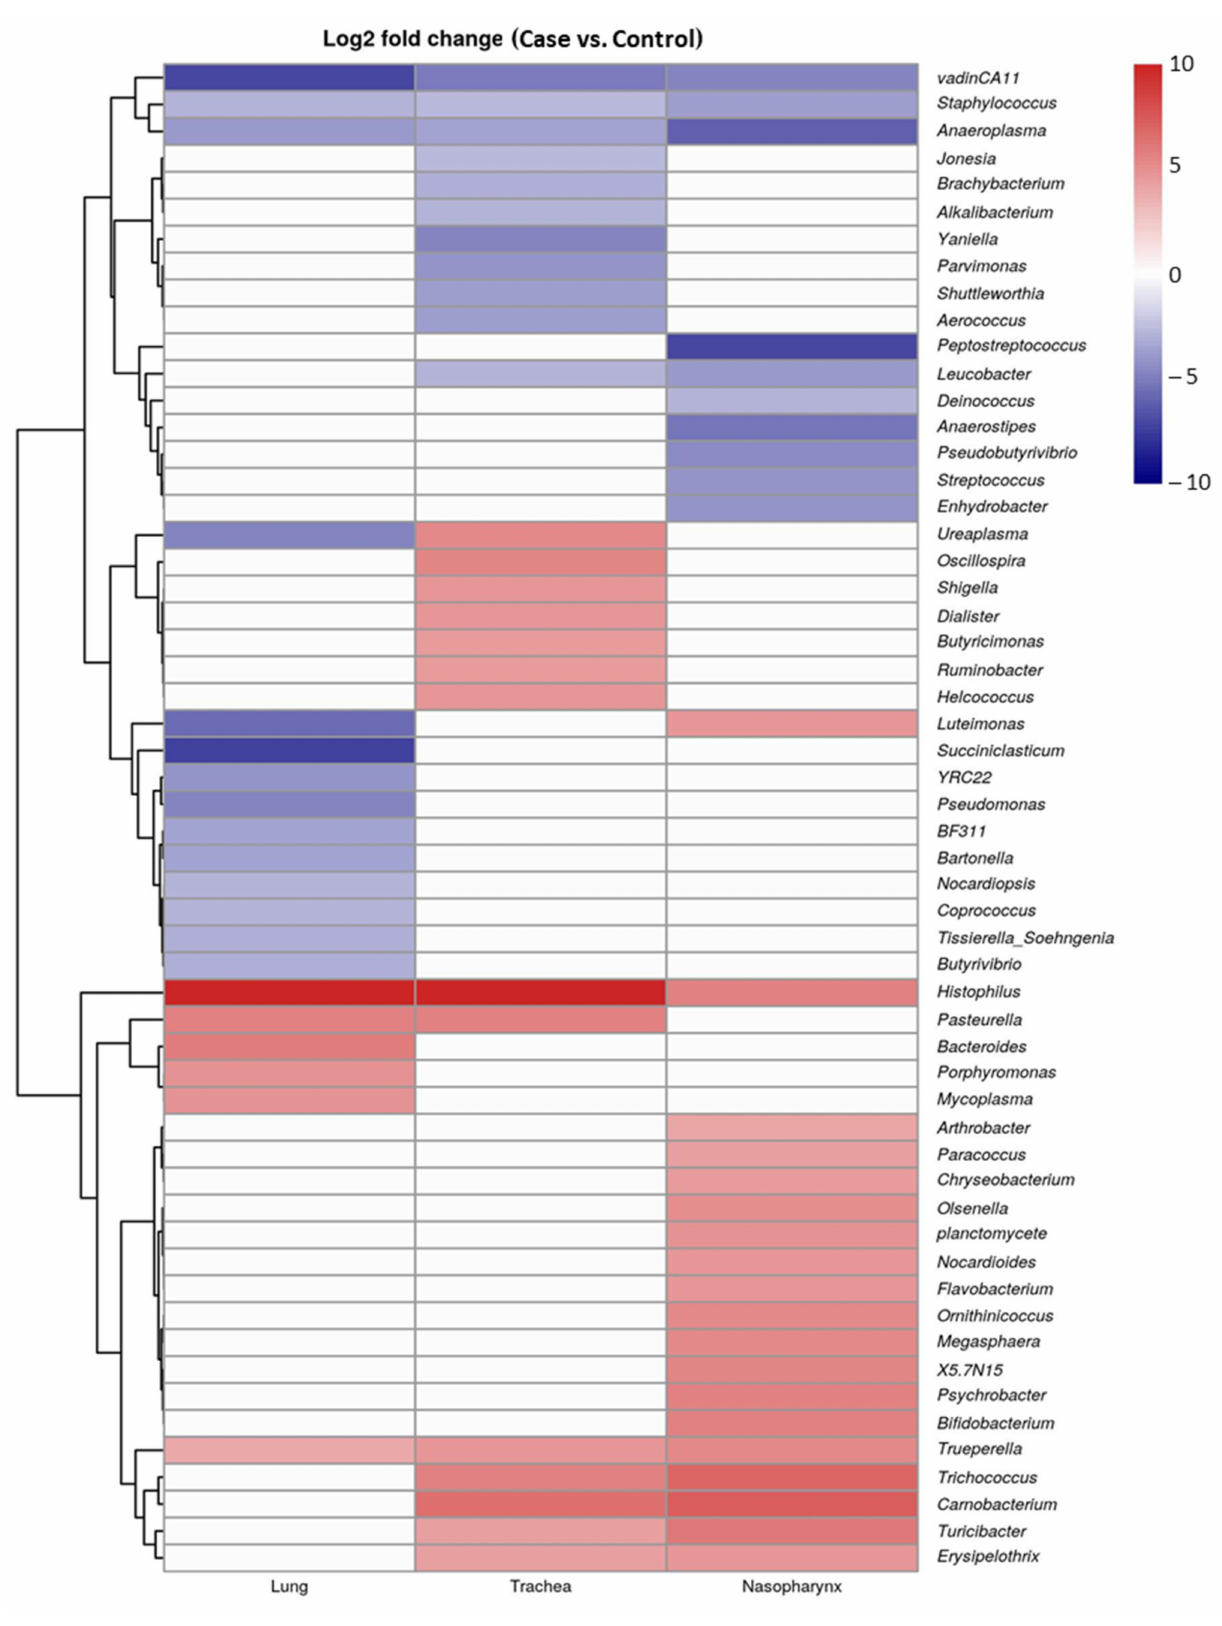
Figure 4. Heatmap of mean relative abundance of bacterial genera identified in respiratory tract samples from BRD cases and